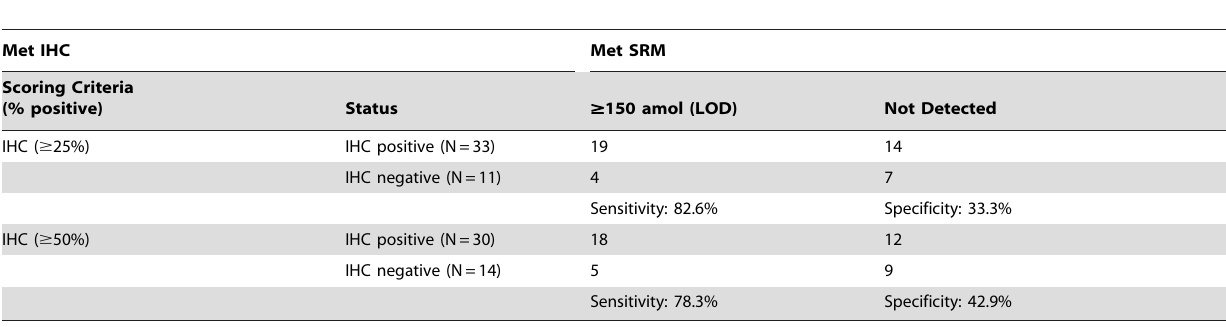
Table 2. Comparison of Met IHC ( $ 25% or $ 50% positivity at any intensity $ 1 + ) with Met protein levels (by SRM) in 44 gastroesophageal cancer FFPE tissues.